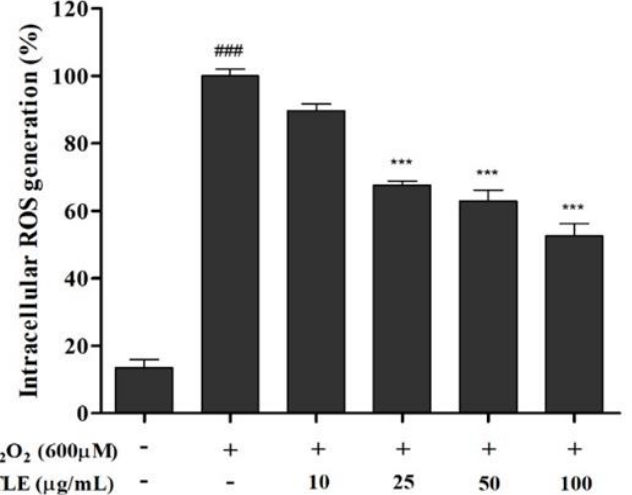
Figure 3. Intracellular reactive oxygen species (ROS) generation in the H 2 O 2 and/or TLE-treated Vero cells. The data were measured in triplicate and expressed as the mean ± SE. *** p < 0.001 compared with the H 2 O 2 -treated group and ### p < 0.001 compared with the untreated group.